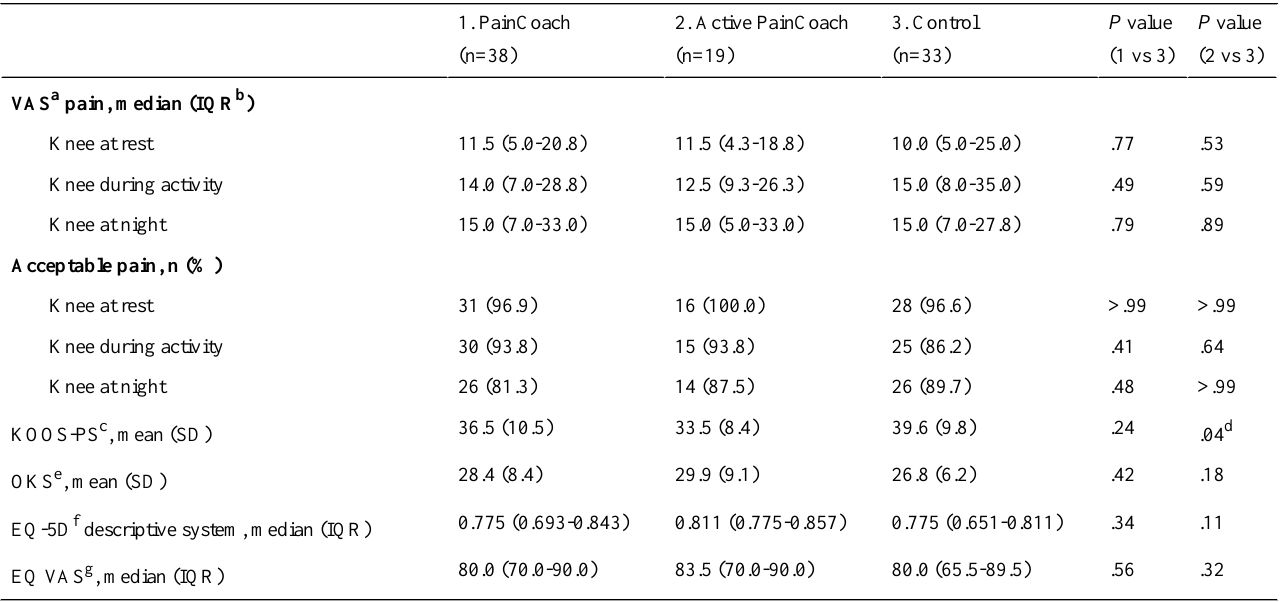
Table 4. Findings in the PainCoach group, active PainCoach subgroup, and control group 1 month after